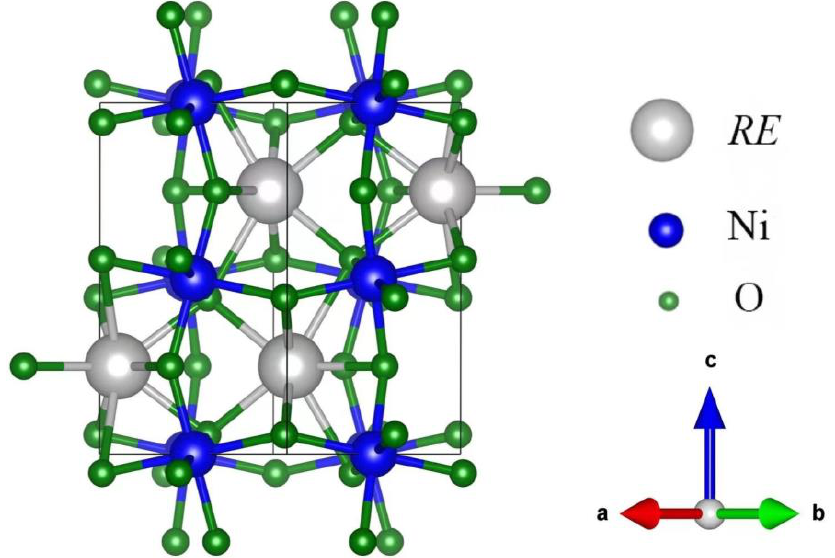
Figure 1. Geometric structure of RE NiO 3